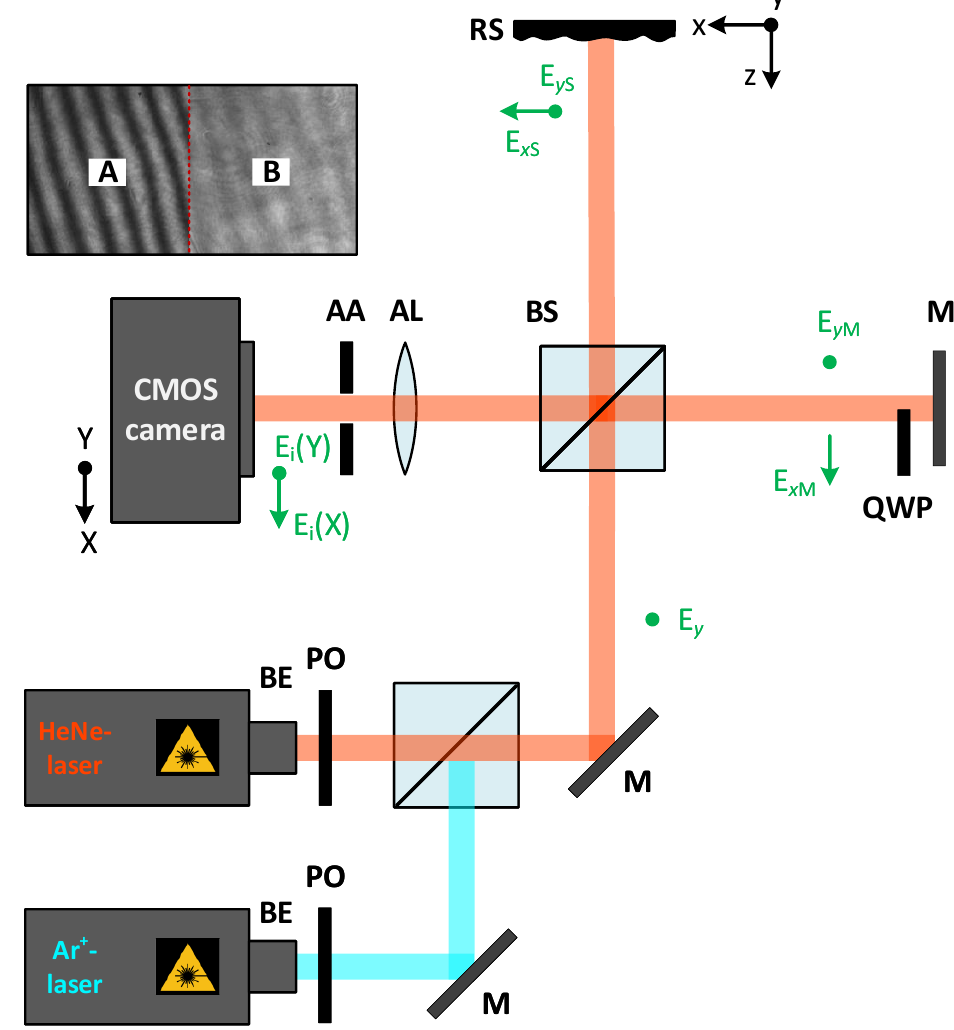
Figure 1. Schematic structure of the experimental setup with the electric field components at different positions (in green) and the resulting interferogram. BE: beam expander; PO: polarizer; M: plane mirror; BS: (non-polarizing) beam splitter; RS: rough surface; QWP: quarter-wave plate; CMOS: complementary metal-oxide semiconductor; AA: adjustable aperture; AL: achromatic